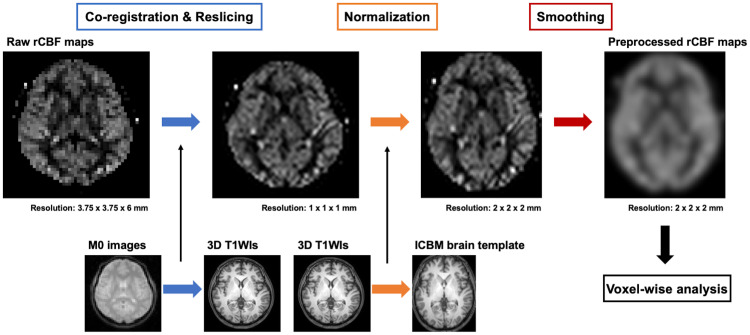
Preprocessing steps of the rCBF maps.